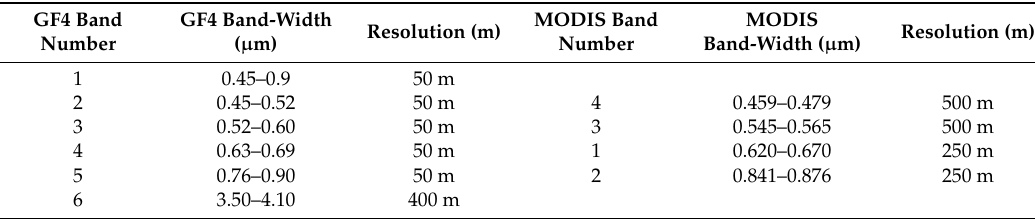
Table 1. Instrument characteristics of GaoFen-4 (GF4) camera (provided by China’s center for resources satellite data and application) and Moderate Resolution Imaging Spectroradiometer (MODIS) instrument.